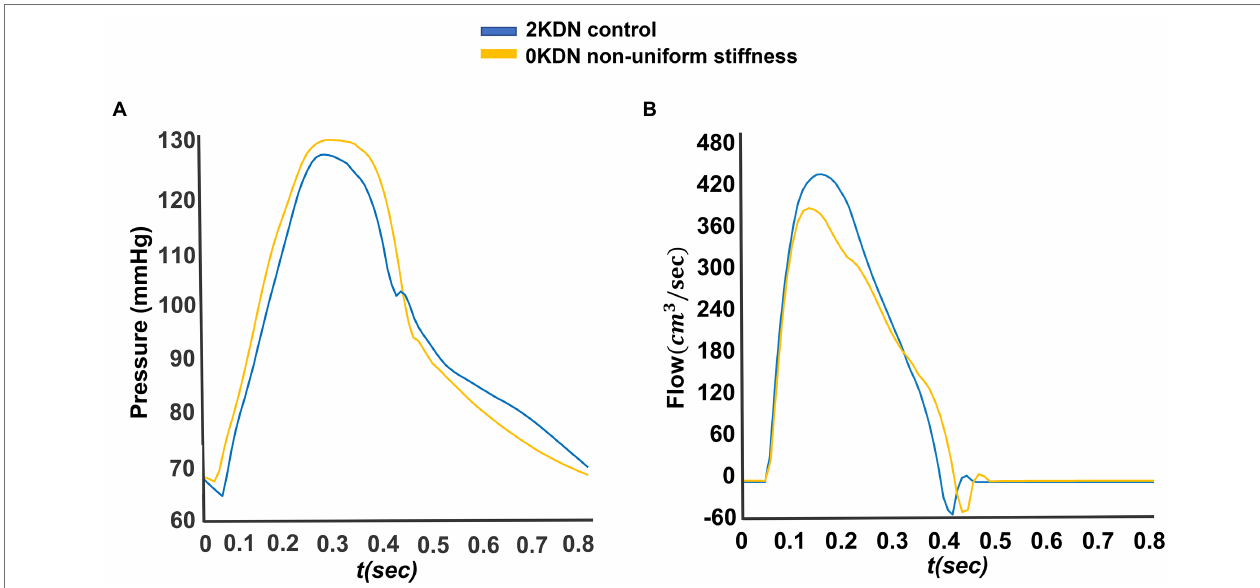
FIGURE 9 | Variations of the aortic pressure and flow waveforms. (A) Pressure waveforms in the non-uniform stiffness configuration without kidneys (0KDN) compared to the default distensibility with 2KDN (control). (B) Flow waveforms in the non-uniform stiffness configuration without kidneys (0KDN) compared to the default distensibility with 2KDN